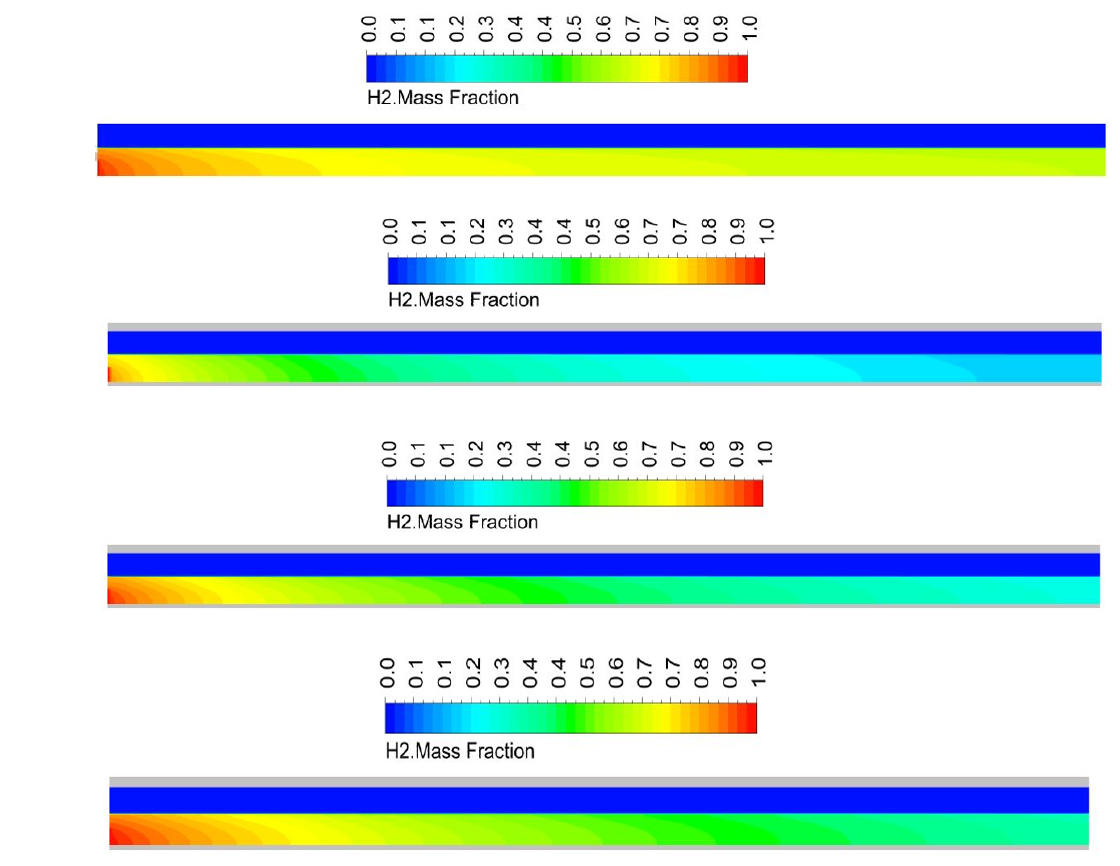
Figure 8. Hydrogen concentration contour through the cell for different designs.